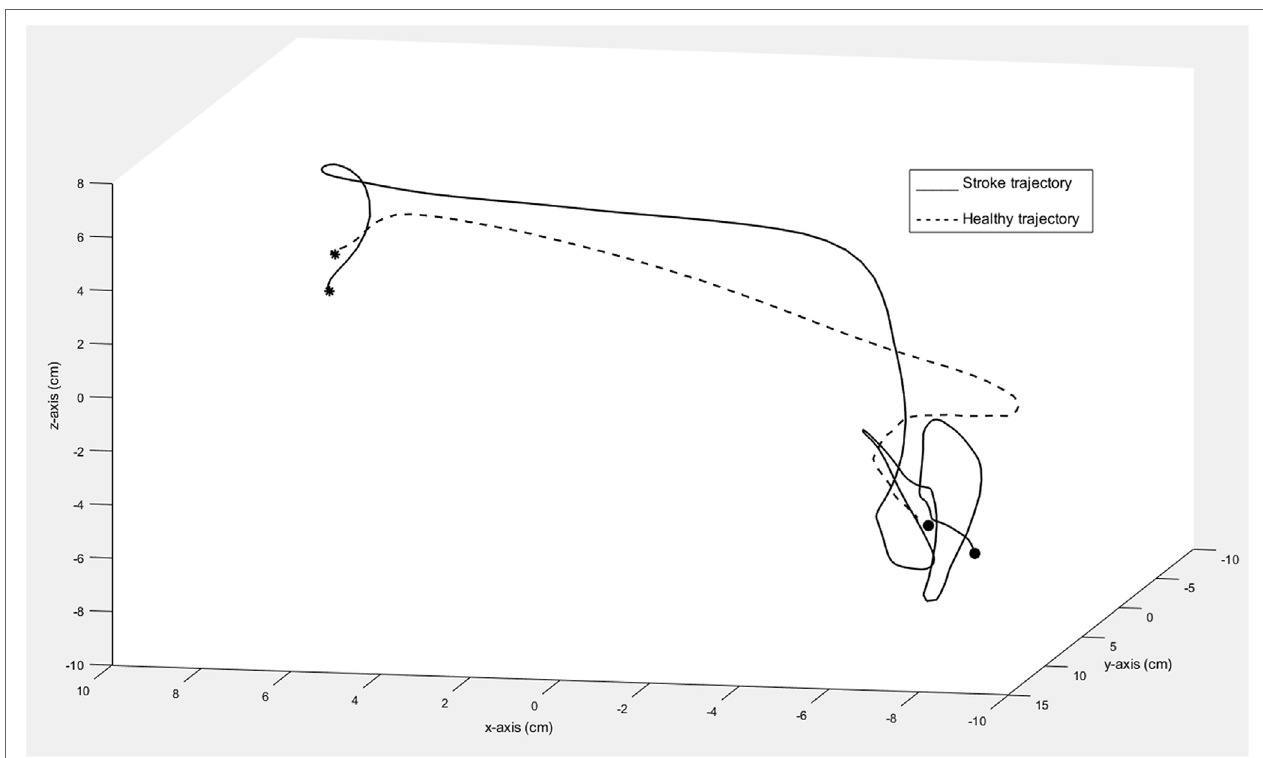
FigUre 4 | Trajectory of one movement segment in 3D space shown for one individual with moderate stroke impairment (solid line) and one healthy control (dashed line). The asterisk marks the start and the circle marks the end of the movement